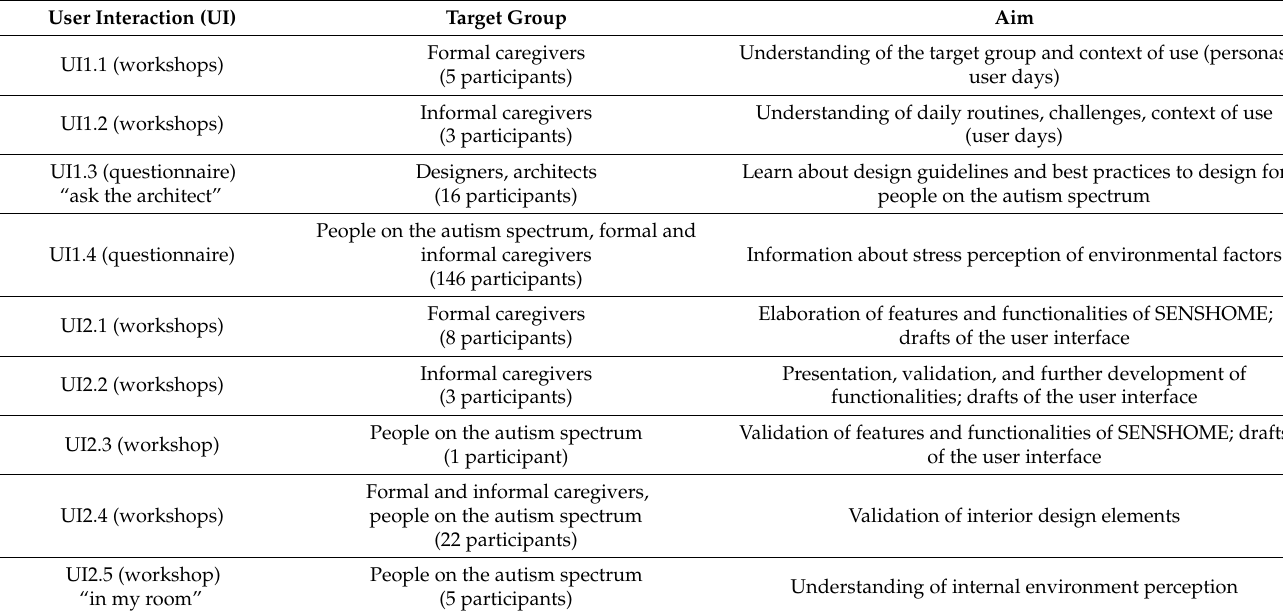
Table 1. Overview of conducted user